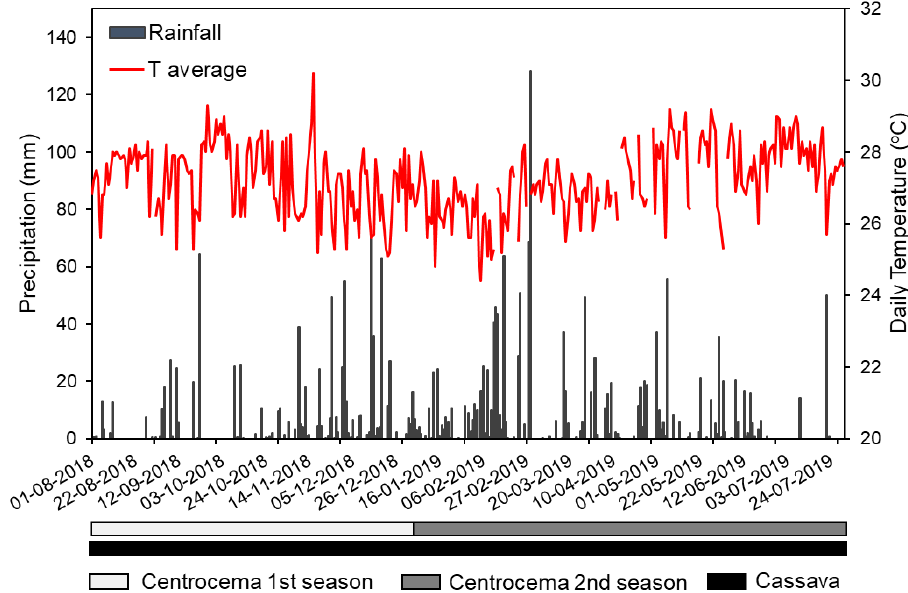
Figure 1. Daily precipitation (mm) and temperature ( ◦ C) during the 2018–2019 growing season. Data were obtained from the Weather Station of Depati Amir, Pangkal Pinang city, Bangka Belitung Islands Province, Indonesia [45].